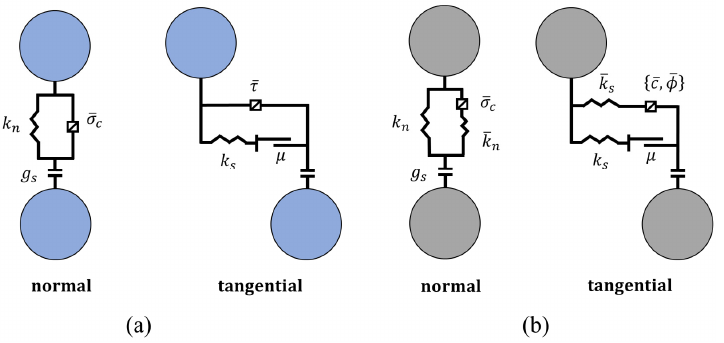
Figure 5. Two typical bond models in the DEM: ( a ) contact-bond model; ( b ) parallel-bond